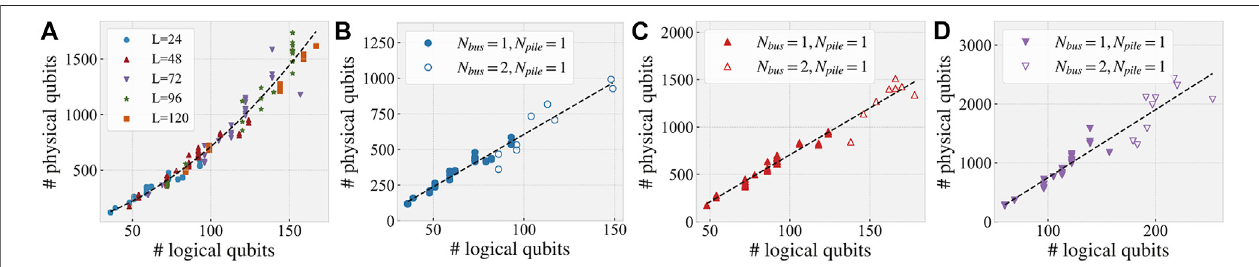
FIGURE1|(A) Thenumber ofphysical qubitsneededtominorembed differentproblems,for fi xed N bus (cid:2) 1, N pile (cid:2) 1and L time ∈ {24,48,72,96,120}.Thedashed lineisaquadraticregression fi t. (B – D) Fixing L time ∈ {24,48,72},andvaryingotherproblemparameters. N bus , N pile .Thedashedlinesarelinearregression fi ts.The16 × 16 Chimera graph from D-Wave 2000q sampler is used for all embeddings except for the large problems in (D) , embedded onto a 24 × 24 Chimera graph.